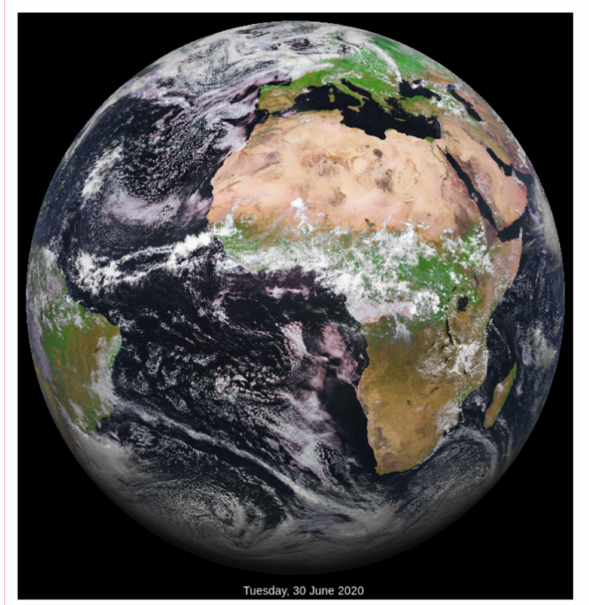
Figure 1. Image acquired the 30 June 2020–12:00 UTC, from broadband visible channel of the satellite Meteosat-11 (i.e., MSG-4) (credit: